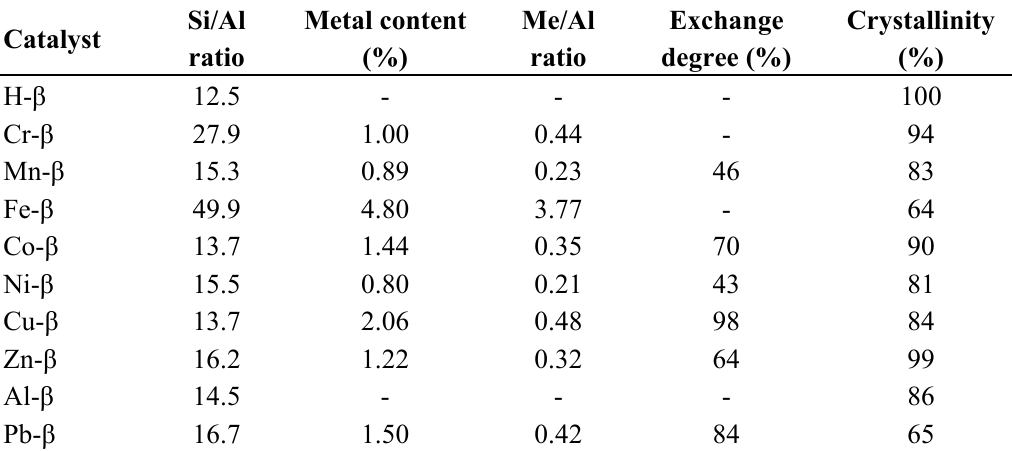
Table 1. Some characteristics of metal exchanged β zeolites 1 .